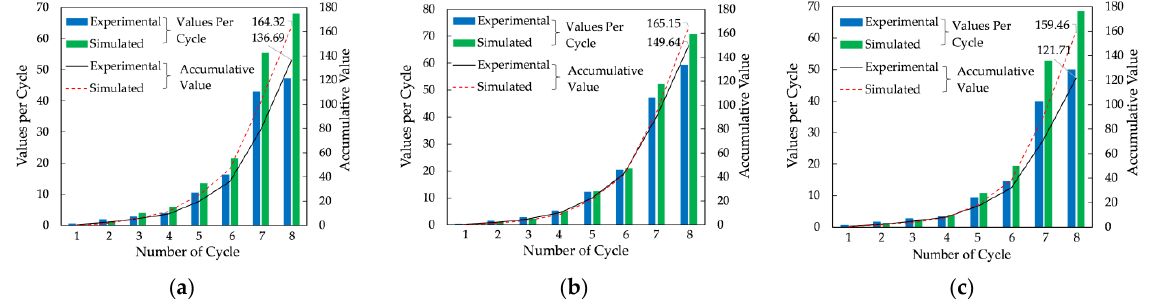
Figure 28. Comparison of hysteric curves of three numerical models. ( a ) CS-1; ( b ) CS-2; ( c ) CS-3.